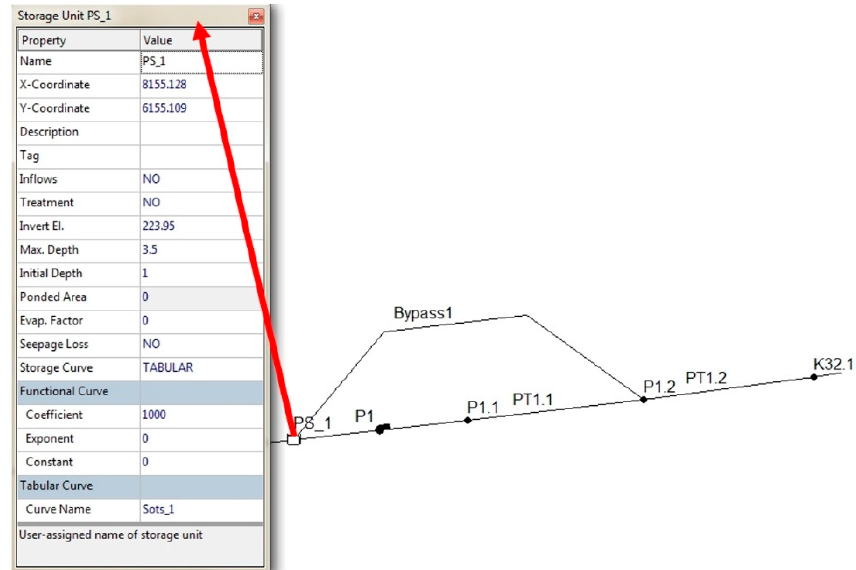
Figure 8. View of the storage unit properties editor acting as the pumping station PS_1.